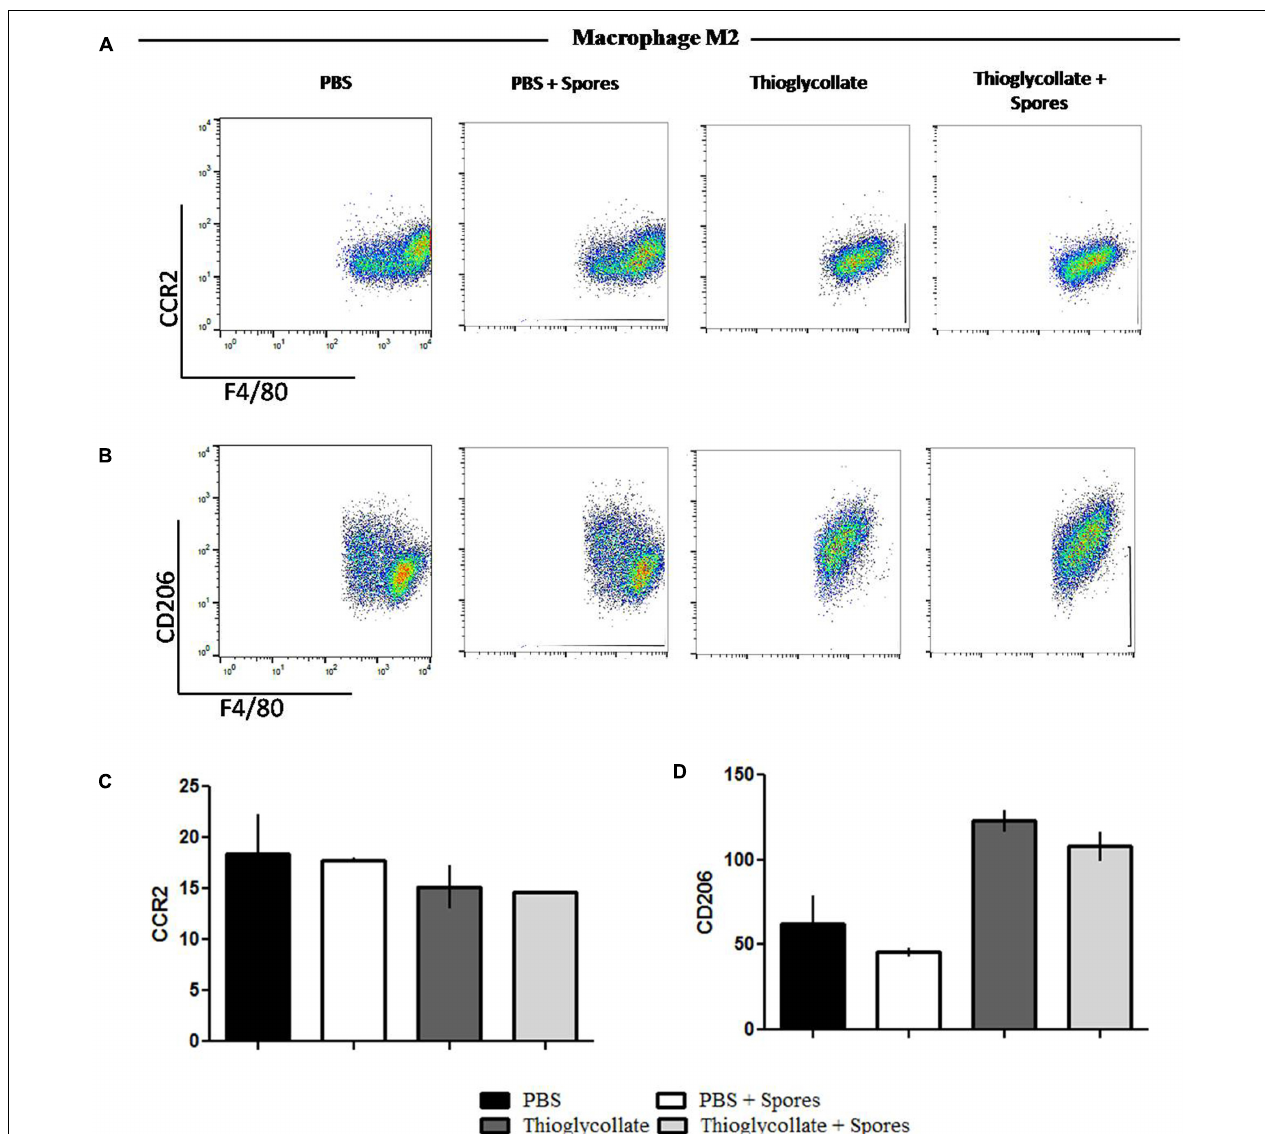
FIGURE 6 | Phenotypical profile of M2 cells from C57BL6 mice peritoneal macrophages. Peritoneal cells obtained from peritoneal wash of C57BL/6 mice treated or not with spores were collected and stained with monoclonal antibodies for M1 profile, (A) CCR2 and (B) CD206. The bars from the graphics represent the median fluorescence intensity (MFI) obtained for the molecules (C) CCR2 e (D) CD206. Data show one histogram representative of three independent experiments with three mice in each group. Results are represented as mean ± SD from one-way ANOVA test followed by Tukey post-test. ∗ p ≤